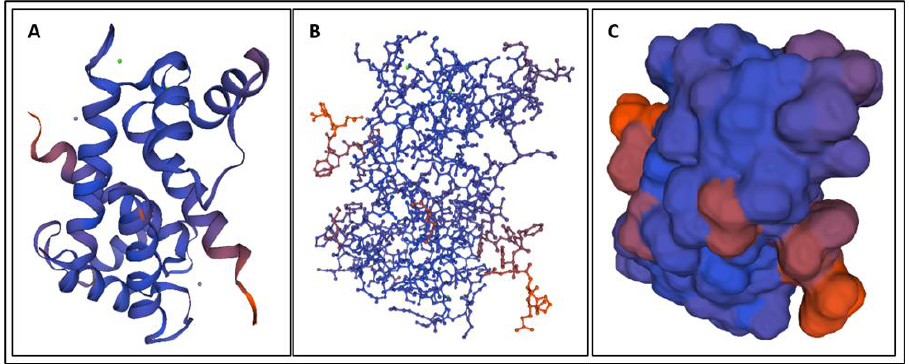
Figure 7. ( A ) A cartoon model, ( B ) a ball-and-stick model, and ( C ) a surface model of S100B [34].